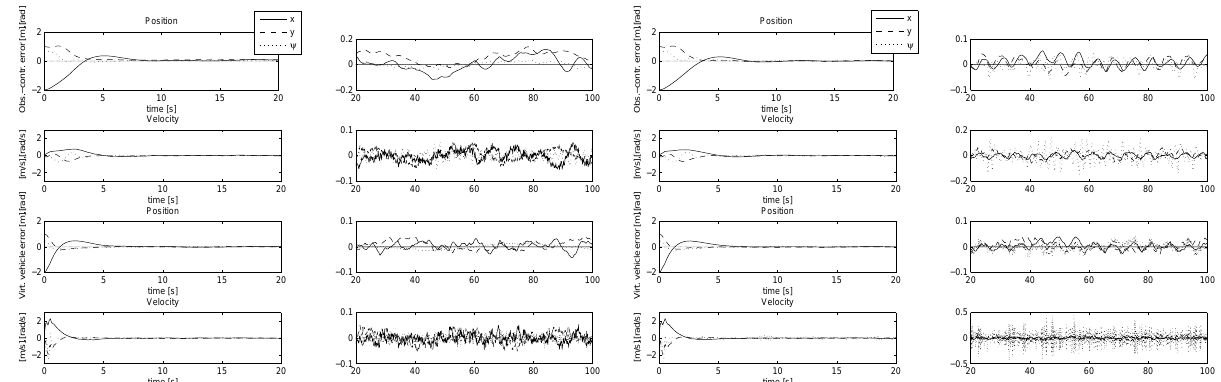
Figure 6: Performance of the dynamic observer scheme (top two rows) and kinematic observer scheme (bot- tom two rows) under force disturbances.